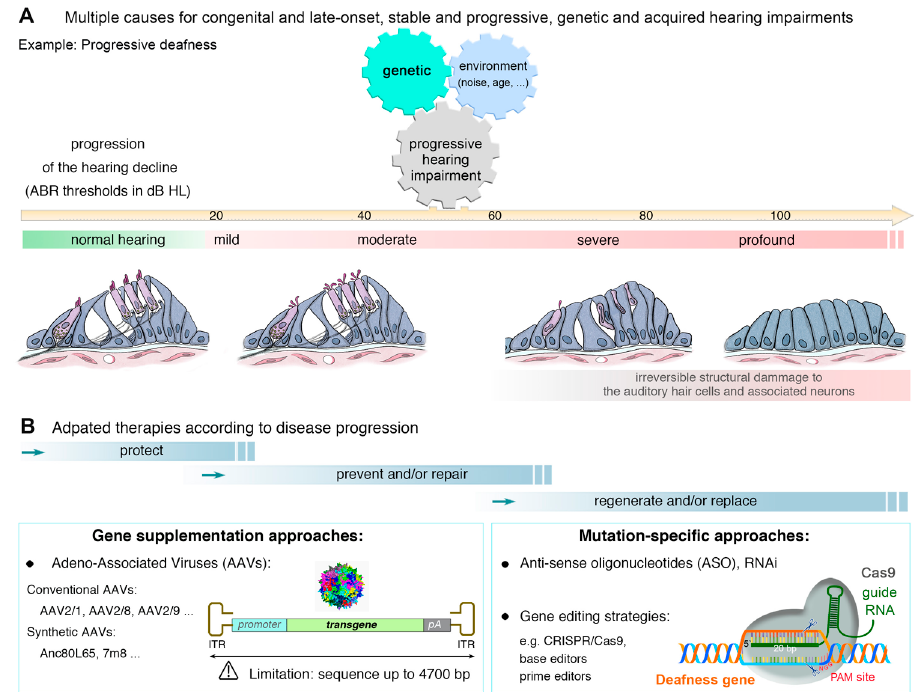
Figure 2. Hearing loss causal origins and adapted therapeutic strategies. ( A ) Hearing loss, defined as